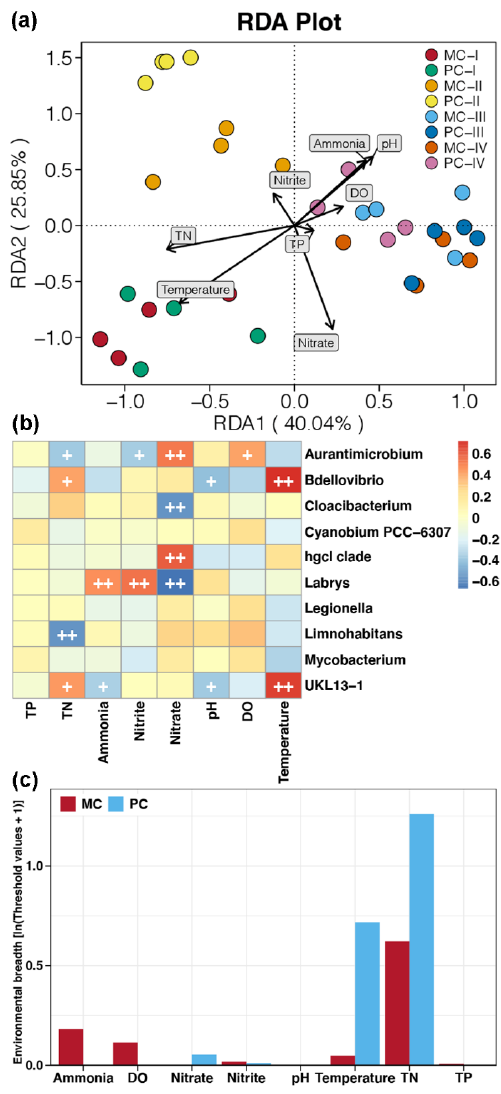
Figure 2. Environmental adaptation of bacterioplankton communities. ( a ) Redundancy analysis evaluating the relationship between bacterioplankton communities and environmental factors